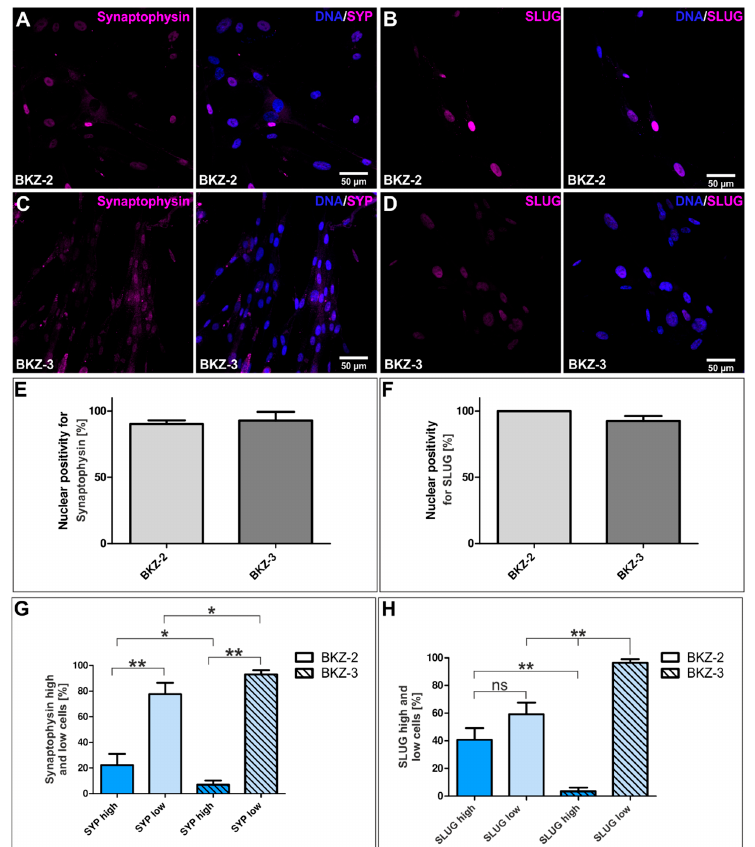
Figure 8. BKZ-2 cells reveal higher levels of Synaptophysin (SYP) and snail family transcriptional repressor 2 (SLUG) protein in comparison to BKZ-3 cells. Immunocytochemical stainings revealed the expression of neuroendocrine and cancer stem cell marker ( A/C ) Synaptophysin as well as the expression of ( B/D ) SLUG, one of the key transcription factors of the process of epithelial to mesenchymal transition in both populations. ( E ) Quantification of cells positive for nuclear Synaptophysin revealed a mean of 90.27% for BKZ-2 and 92.92% for BKZ-3. ( G ) Further classification in Synaptophysin high and low cells, showed a significantly higher amount of Synaptophysin low nuclei in comparison to Synaptophysin high nuclei for both BKZ-2 and BKZ-3. However, BKZ-2 revealed a significantly higher percentage of Synaptophysin high nuclei in comparison to BKZ-3. ( F ) Quantification of nuclear positivity for SLUG displayed 100% positive cells for BKZ-2 and a mean of 92.57% positive cells for BKZ-3. ( H ) Comparison of SLUG high and low cells displayed a significantly higher amount of SLUG high cells of BKZ-2 when compared to BKZ-3. Moreover, BKZ-3 cells in general showed a significantly higher percentage of SLUG low cells in comparison to the amount of SLUG high cells. Non-parametric Mann-Whitney-test ( p ≤ 0.05). n = 3, ** p ≤ 0.01, * p ≤ 0.05, ns = not significant. Mean ± SEM (standard error of the